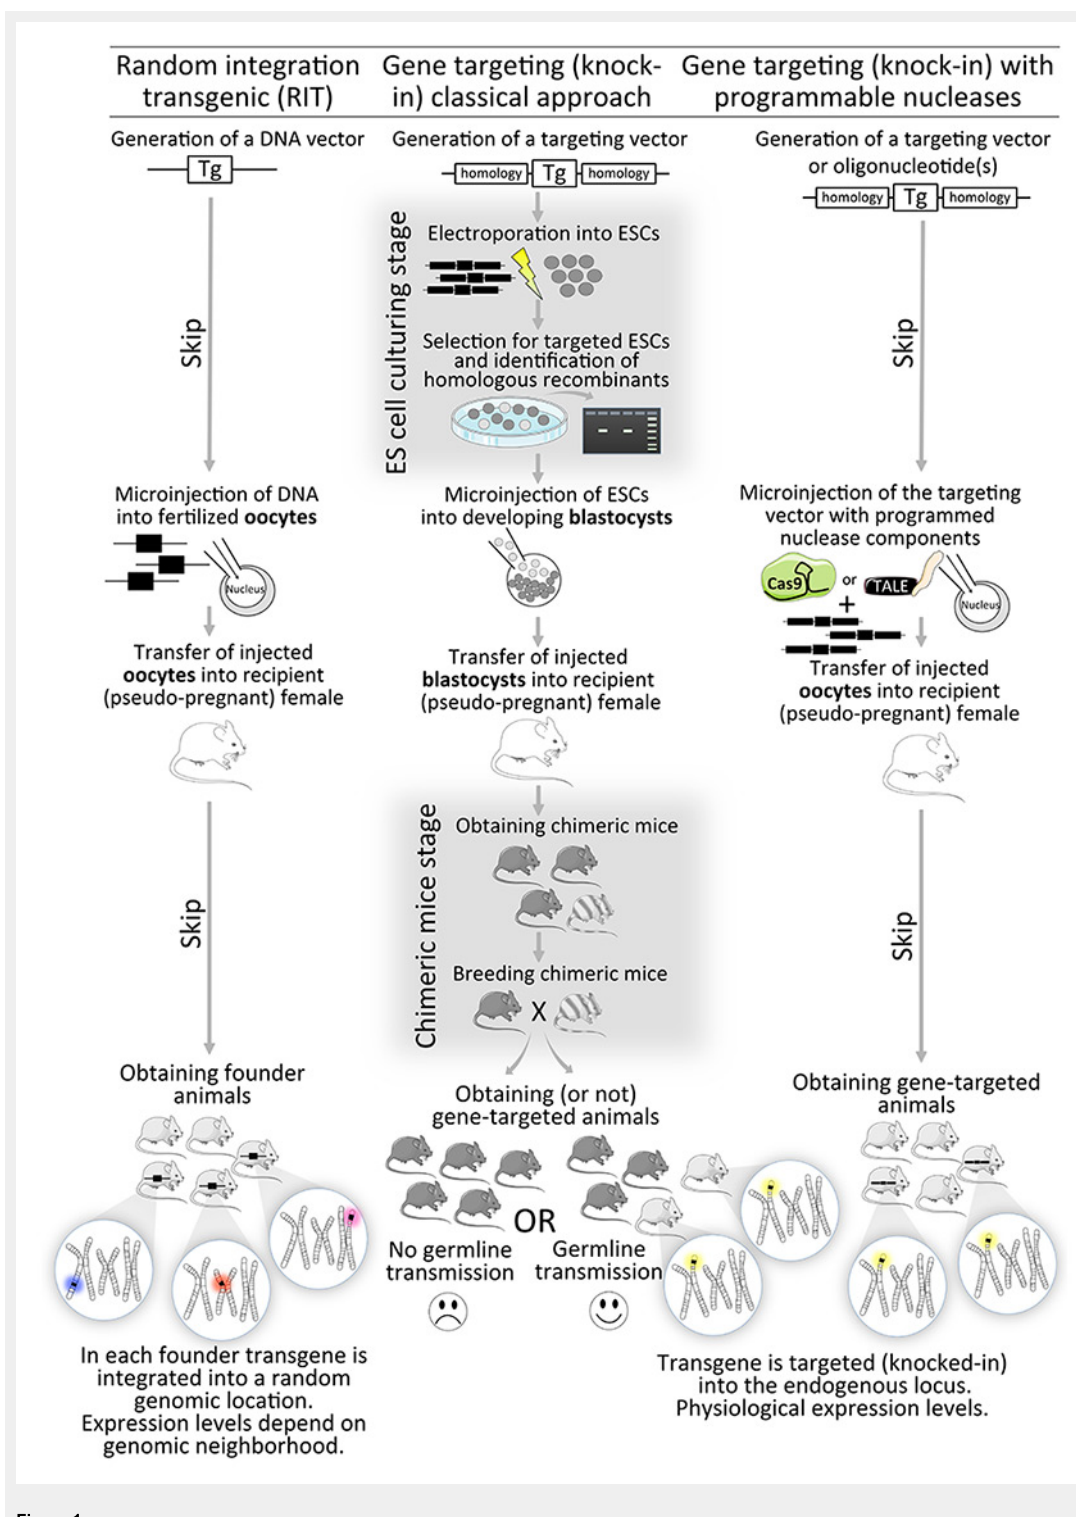
A comparison of strategies to genetically engineer mice. The random integration approach (left workflow) is useful for adding new genes, and is technically straightforward, but suffers from position effects (transgenes on different chromosomes on the bottom). The gene targeting approach (middle workflow) is more laborious, requiring embryonic stem cell (ESC) culturing, and breeding of chimeras, which often fail to transmit the transgene to their progeny. The breakthrough of the gene targeting approach employing guided nucleases (right workflow), is that the final result of gene-targeted mice is obtained without the ESC culturing and chimera breeding